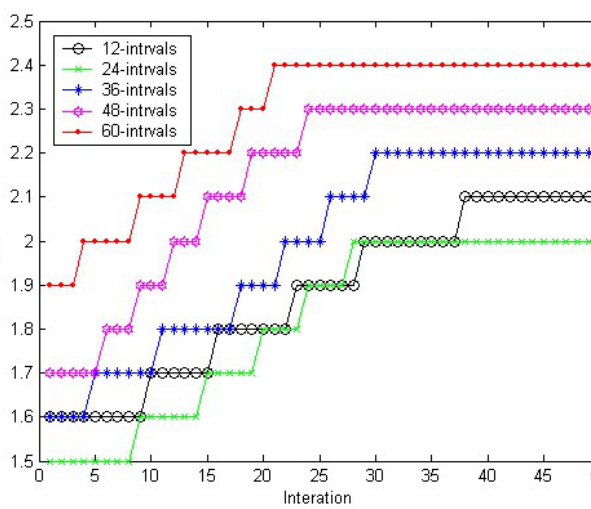
Figure 11. The convergent characteristics of the different time stages.